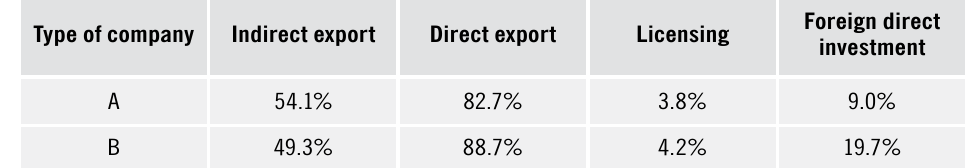
Table 3. A- and B-type companies versus modes of foreign market entry Type of